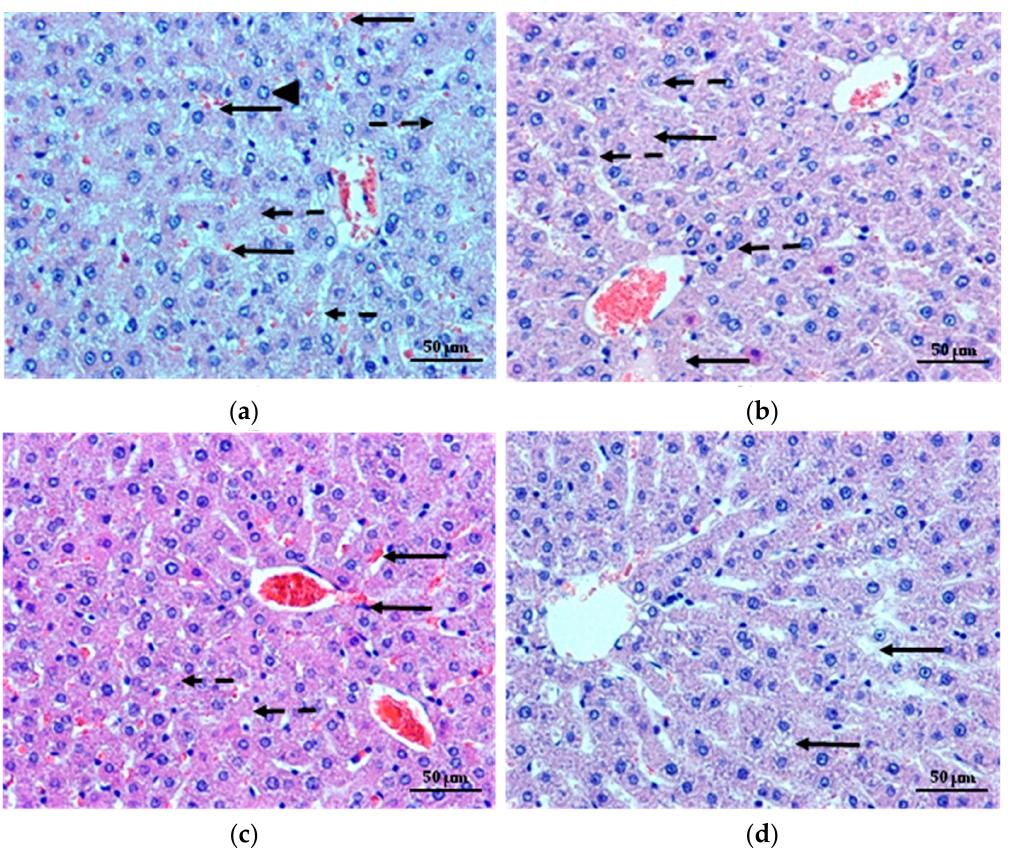
Figeu 8 Figure 8. Representative hematoxylin and eosin stained paraffin liver section of diabetic rats ( a ) shows sinusoidal congestion (arrows), the bloated hepatocytes with vacuolar degeneration (arrowhead) and necrosis of the hepatocytes (mainly around the central vein, dashed arrows). Liver of diabetic rats treated with MF ( b ) depicts areas of micronecrosis (arrows) and hepatocytes with vacuolar degeneration (dashed arrows). In liver of diabetic rats treated with non cross-linked microparticles formulation ( c ), a slight congestion (arrows) and vacuolization of the hepatocytes cytoplasm with a low intensity (dashed arrows) is seen. Liver of diabetic rats treated with cross-linked microparticles formulation CH1M ( d ) shows normal structure of hepatocytes with only a few degraded cells (arrows). Magnification × 200.